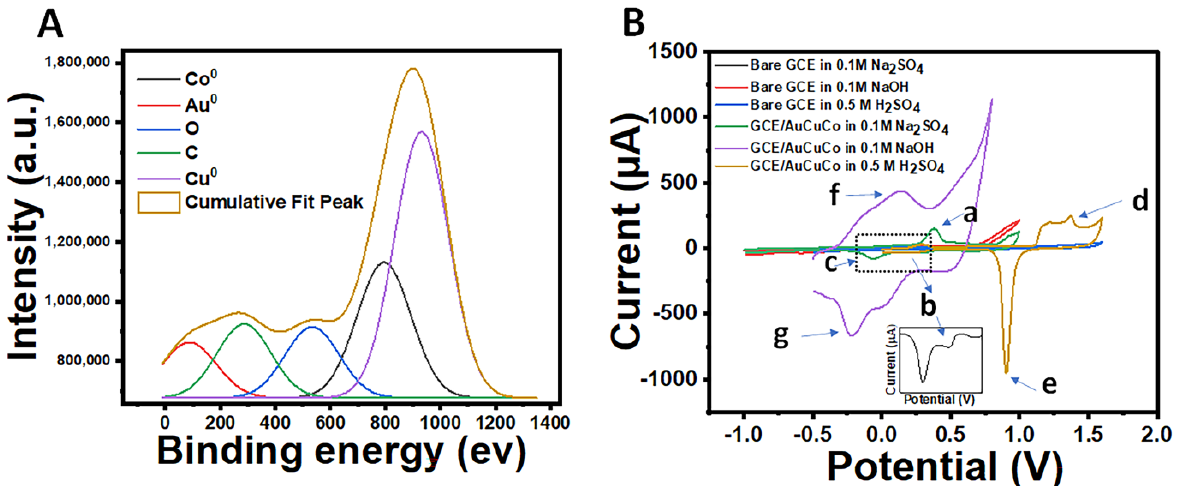
Figure 2. SEM images of imprinted trimetallic NDs at 10 µ m and 5 µ m magnification, respectively, on disposable SPCE ( A , B ).